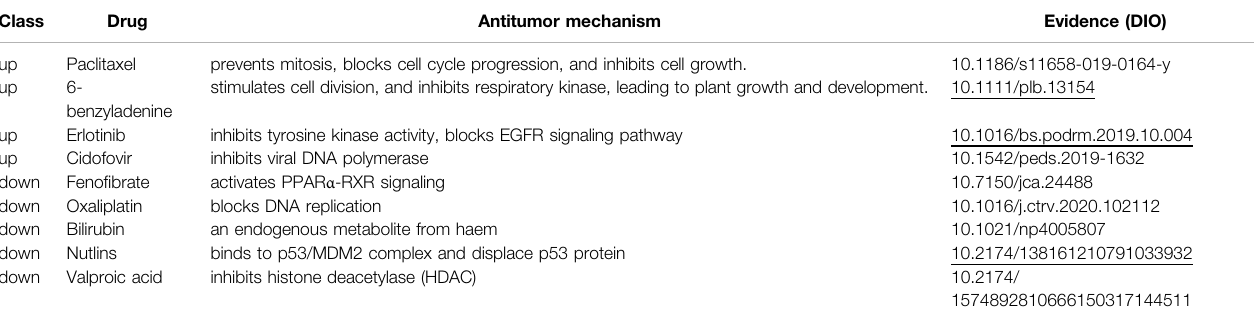
TABLE 1 | Potential drugs for the treatment of LGG